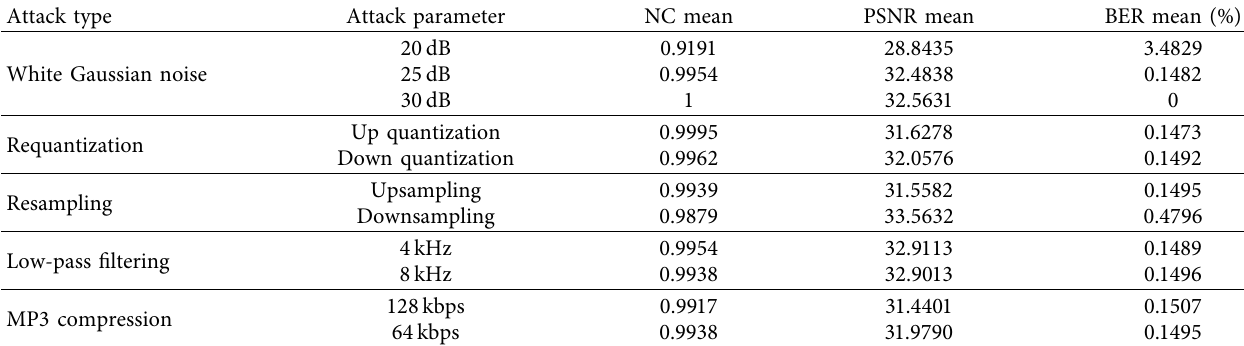
Figure 17: NC mean under H.264 and other attacks. Table 2: Experimental results of audio robustness.